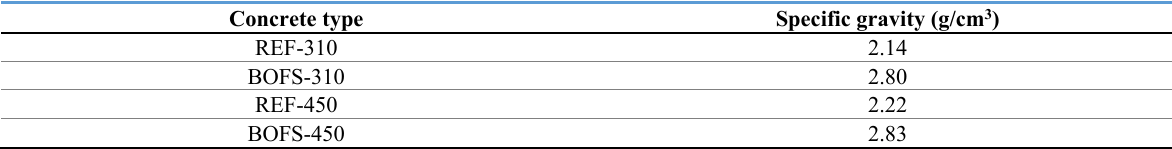
Table 6. Specific gravity of the produced concretes